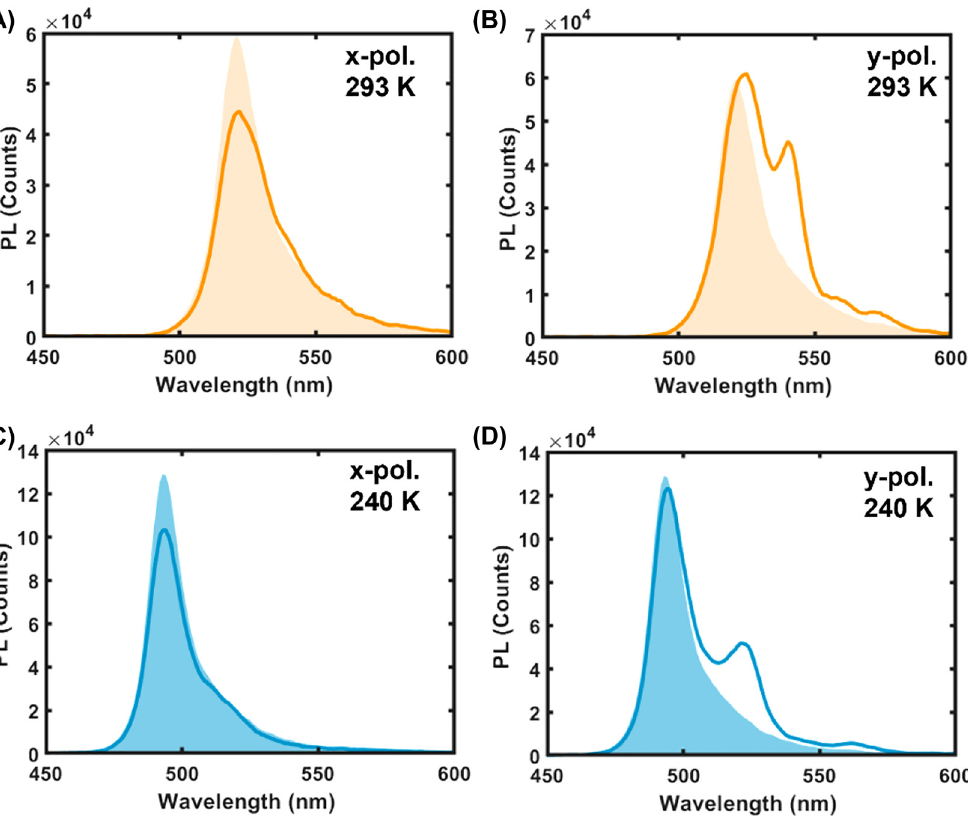
PbI nanograting metasurface upon phase transition. 2 4 PbI nanograting metasurface at 293 K (orange curves): the orange-shaded areas are the 2 4